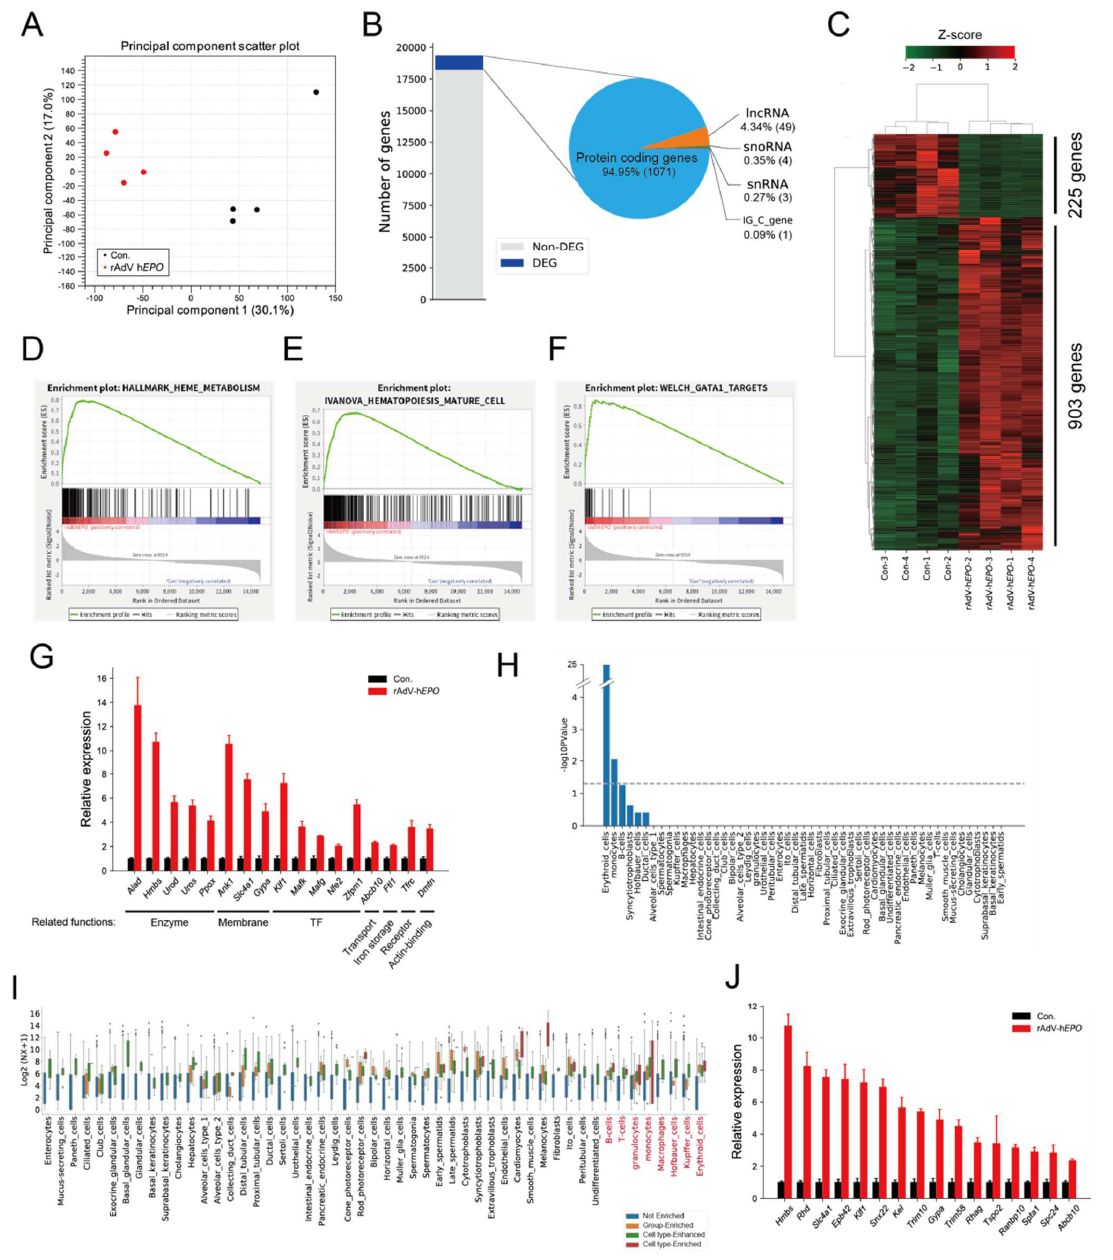
Figure 3. Hematopoietic changes caused by rAdV-h EPO supporting the whole-blood RNA-seq findings. ( A ) PCA plot showing similarities between samples. ( B ) Bar plot and pie chart showing the 1128 DEGs included among all detected genes in whole blood and rates of the gene types. ( C ) Heat map indicating the DEG profile. Values in the rows are z-scores. GSEA showing enriched terms: heme metabolism ( D ), hematopoiesis mature cell ( E ), and GATA1 target ( F ) terms. ( G ) Relative gene expression levels (Con. = 1.0) showing gene expression in the GATA1 target term in ( F ). Biological-related functions are described under gene names. The genes were visualized according to the GSEA enrichment results with a “Yes” value. Error bars indicate the standard error of the mean (SEM). ( H ) Bar plot showing the CTSA to predict cell-type-specific gene enrichment in DEGs. The gray line represents a significant threshold ( p < 0.05). ( I ) Box plot showing single-cell gene normalized expression (“NX”) of DEGs in each cell type. Single-cell gene expression levels of DEGs were classified by cell-type-specific definitions by TissueEnrich for each cell-type. ( J ) Relative gene expression levels (Con. = 1.0) showing erythroid cell-enriched gene expressions in DEGs. Abbreviations: long non-coding RNA (lncRNA), small nucleolar RNA (snoRNA), small nuclear RNA (snRNA), and immunoglobulin constant germline gene (IGC